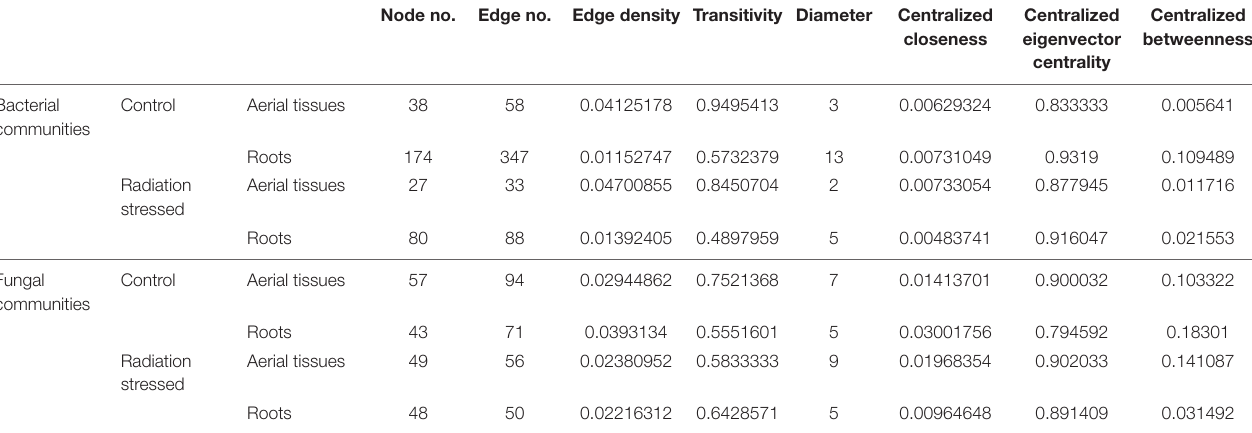
TABLE 1 | The properties of co-occurrence networks of endophyte communities, which is combined from networks of four seasons.